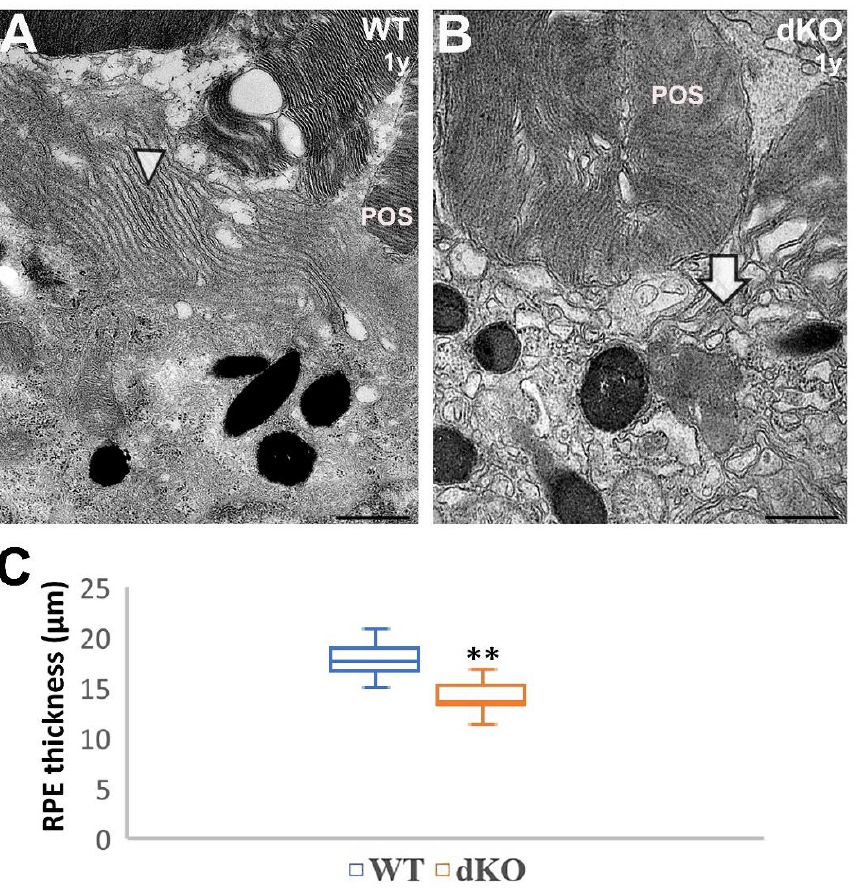
Figure 4. Loss of apical microvilli and flattened RPE in one-year-old NFE2L2/PGC-1 α dKO mice as compared with their age-matched wild-type (WT) littermates. Panel 4 A shows the apical portion of WT RPE, where microvilli (arrowhead) are arranged normally, surrounding the photoreceptor outer segments (POS). In contrast, many of the apical portion of RPEs from dKO mice showed loss of apical microvilli: only a few microvilli on the apical surface were evident ( B ; arrow), with an increased density of melanin granules. Total RPE height from TEM graphs was measured in the region located 300 μm from the optic nerve head ( C ). Combined results from n = 6 animals, ** p < 0.001 (Mann-Whitney U-test). Scale bars: 1 µm ( A , B ).